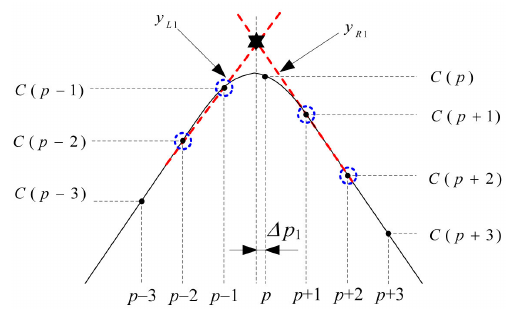
Figure 5. Estimation of ∆ p 1 using C ( p ± 1 ) and C ( p ± 2 ) .